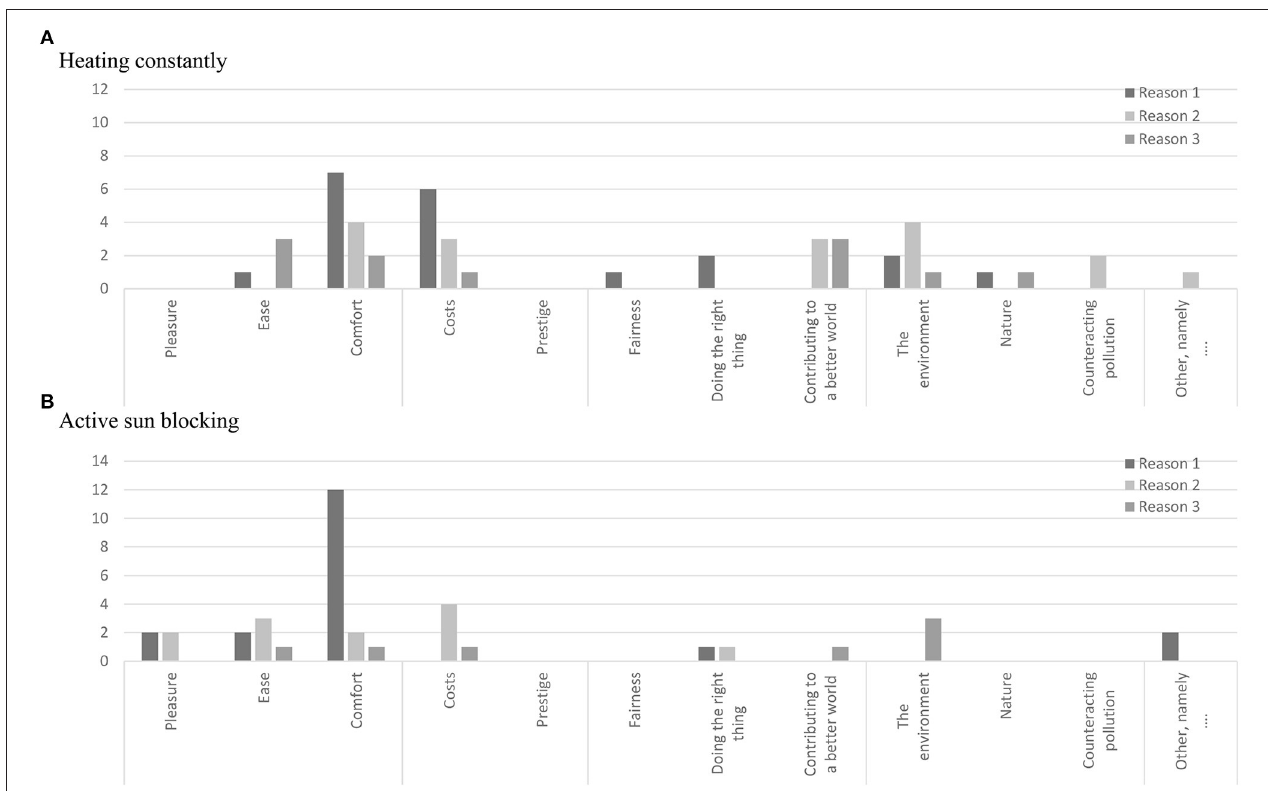
FIGURE 2 | Overview of values mentioned by residents as important for performing the two specific sustainable behaviors; (A) heating constantly and (B) active sun blocking, including number of times each value was mentioned as first, second, and third reason to perform the